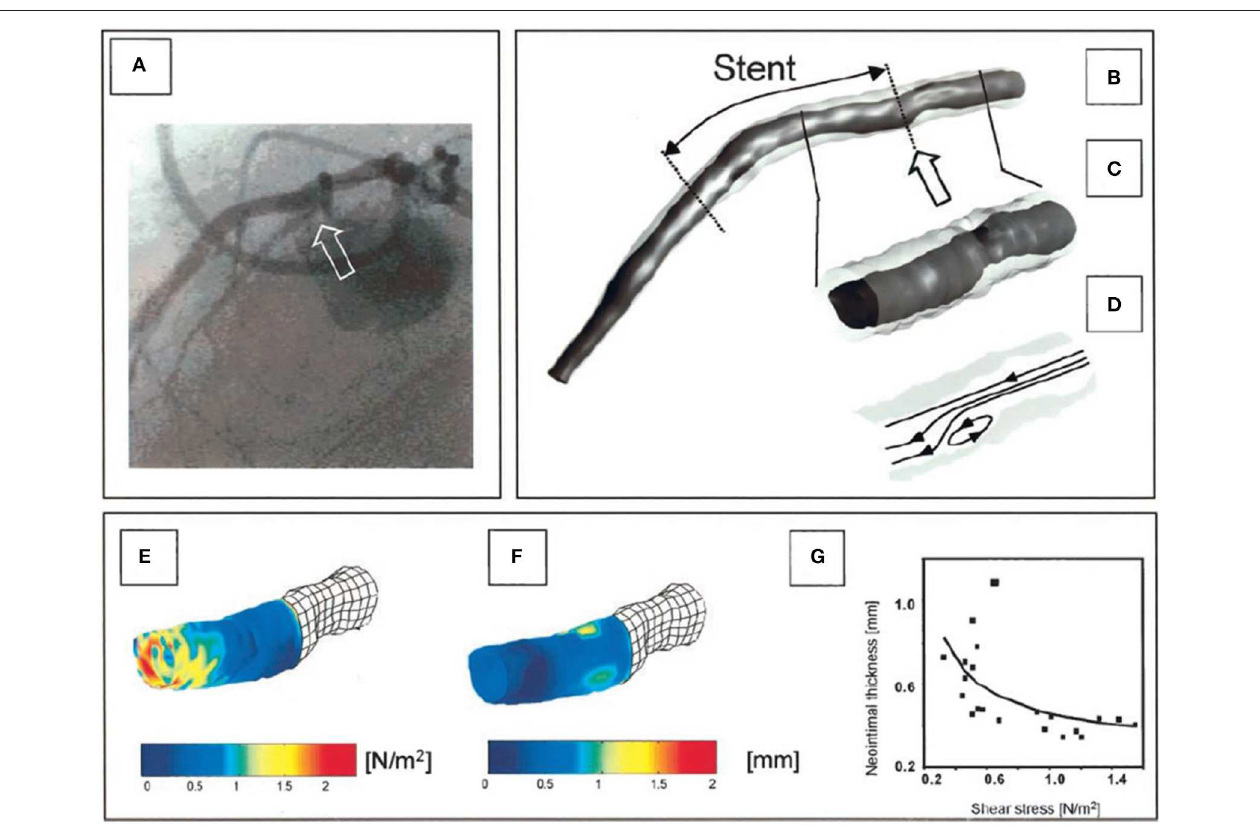
FIGURE 2 | One of the first applications of in vivo 3D-reconstruction modeling that examined the role of ESS on neointima formation. (A) shows an angiographic projection of the left anterior descending coronary artery treated with bare metal stents; the arrow indicates a step-up at the proximal segment of the stent. (B) shows the coronary artery model post stent implantation reconstructed from the fusion of X-ray angiography and IVUS; the outer vessel wall surface is shown in a semi-transparent fashion. The arrow indicates the step-up location noted in the angiographic images; (C) shows a magnified view of that segment while (D) portrays the blood flow streamlines estimated after blood flow simulation; a recirculation zone is noted at the step-up site. At that location low ESS are noted (E) that co-localize with increased neointima proliferation noted in the vessel model at 4 months follow-up (F) . A significant inverse association was reported between ESS and neointima thickness at follow-up (G) . The figure was obtained with permission from Thury et al.